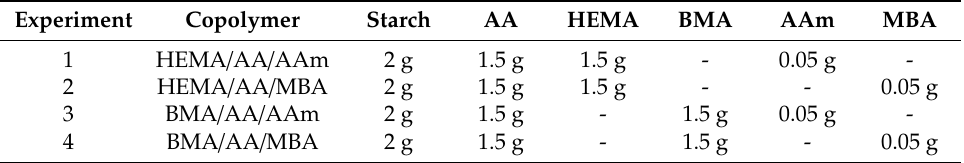
Table 1. Summary of copolymerization experiments: amount of comonomers and crosslinker.